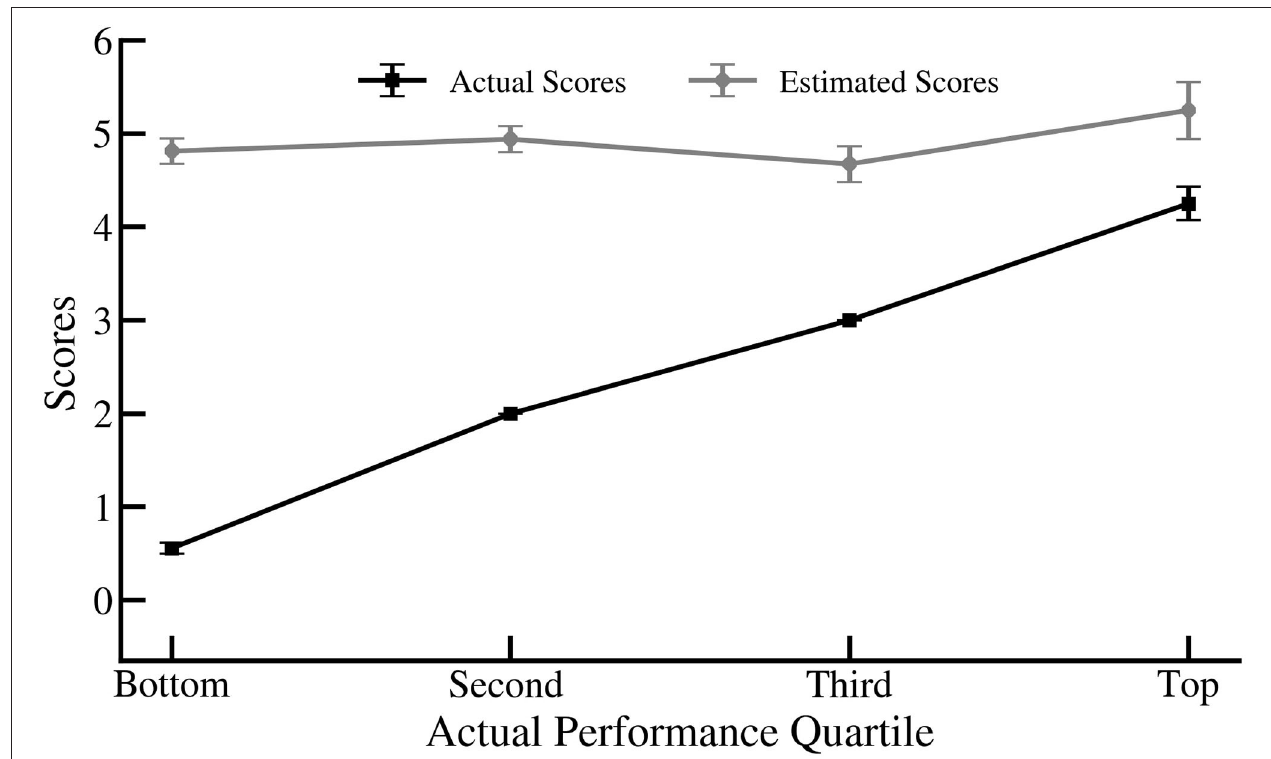
FIGURE 1 | Estimated and actual scores for each performance quartile. Error bars indicate standard